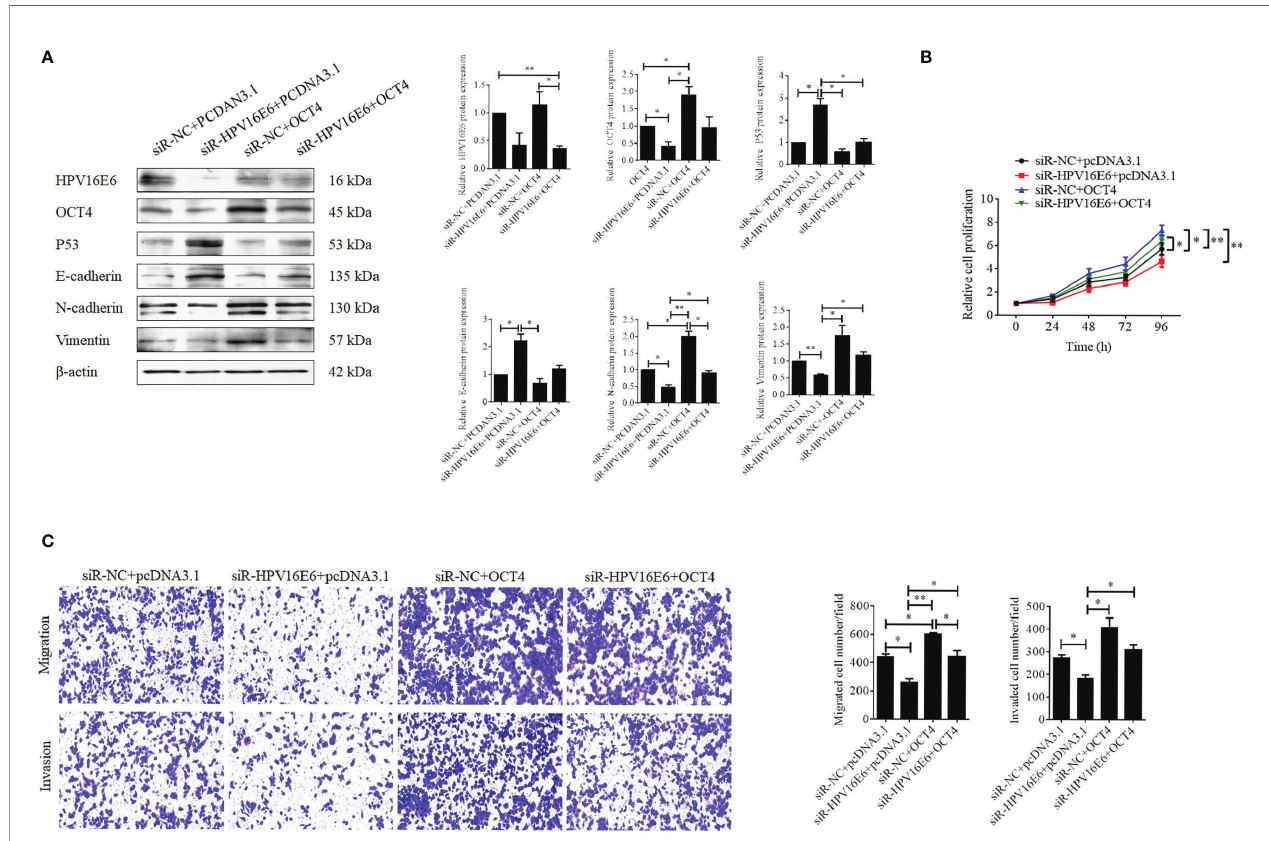
FIGURE 3 | OCT4 overexpression blocked HPV16 E6 silencing inhibiting cell proliferation, migration, invasion, and EMT in human cervical cancer cells. (A) The SiHa cells were co-transfected with HPV16 E6-siRNA and/or pcDNA-OCT4 for 24 h. Then, the protein levels of HPV16 E6, OCT4, p53, E-cadherin, N-cadherin, and vimentin were detected by the Western blot assay. (B) MTT assay analysis of proliferation ability in SiHa cells treated as in (A) . (C) Transwell assay analysis of migration and invasion abilities in SiHa treated as in (A) . * p < 0.05, ** p < 0.01 vs.